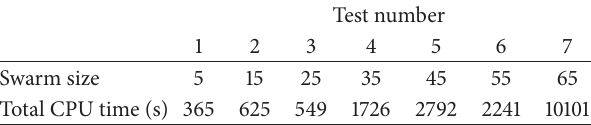
Table 2: Results of sensitivity tests on swarm size.